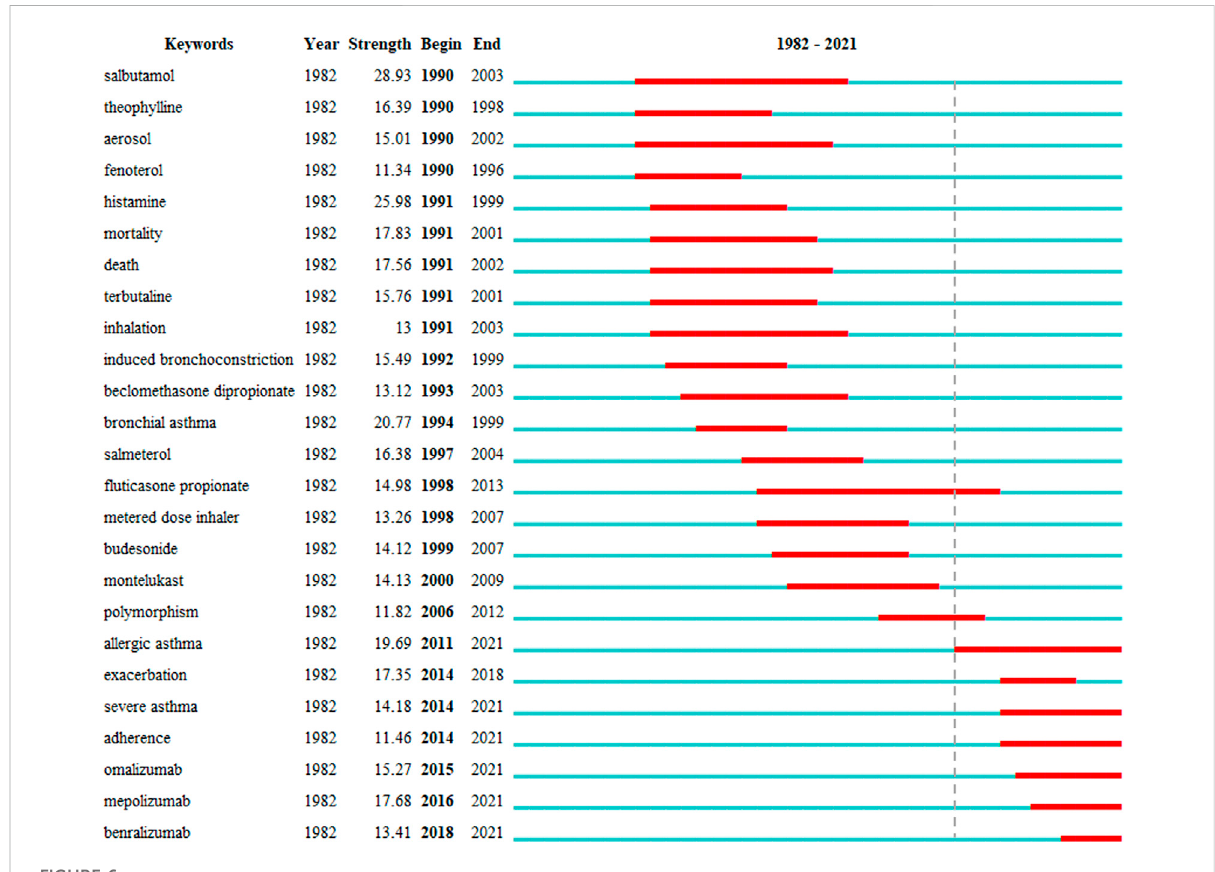
FIGURE 6 Top 25 keywords with strongest citation bursts in asthma drug-related